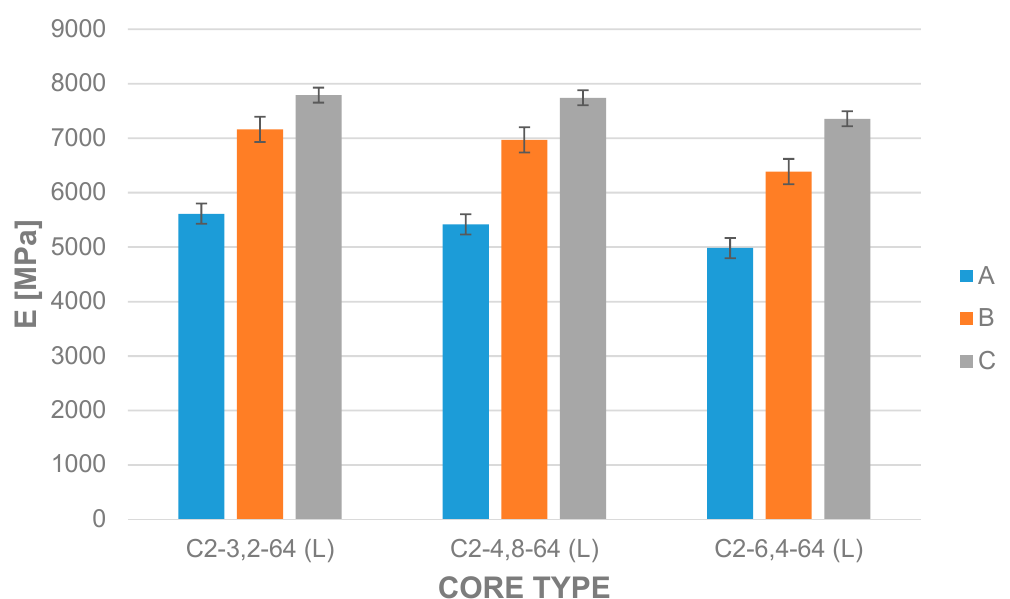
Figure 11. Influence of honeycomb geometry with mesh size (3.2, 4.8, and 6.4) mm on the bending strength of sandwich constructions A–C.